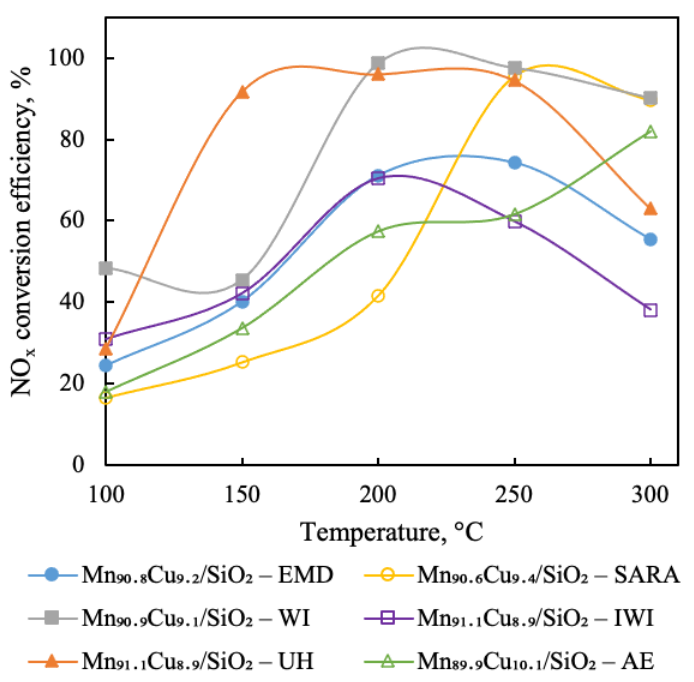
Figure 9. Catalytic performance of the Mn–Cu oxide catalysts supported by the silica gel powder for NO x conversion with ammonia: NO/NH 3 ratio ~1.0; NO ~300–500 ppm, O 2 ~3–5%; volumetric gas flow rate ~0.105 L·min −1 ; GHSV ~450 h −1 ; contact time—8 s.